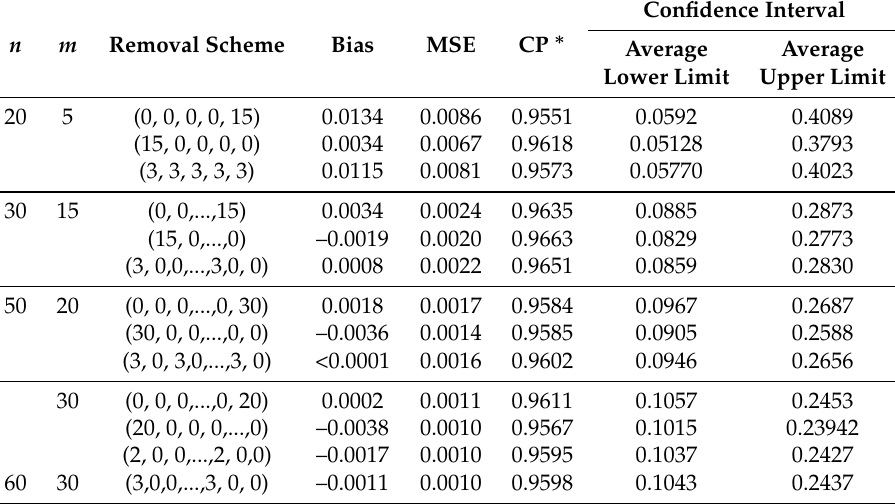
Estimation results of δ s , k using the parametric percentile bootstrap method